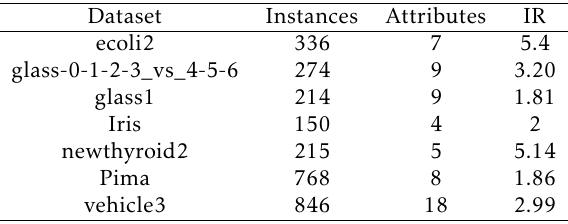
Table 1. Description of the datasets used in the experiments